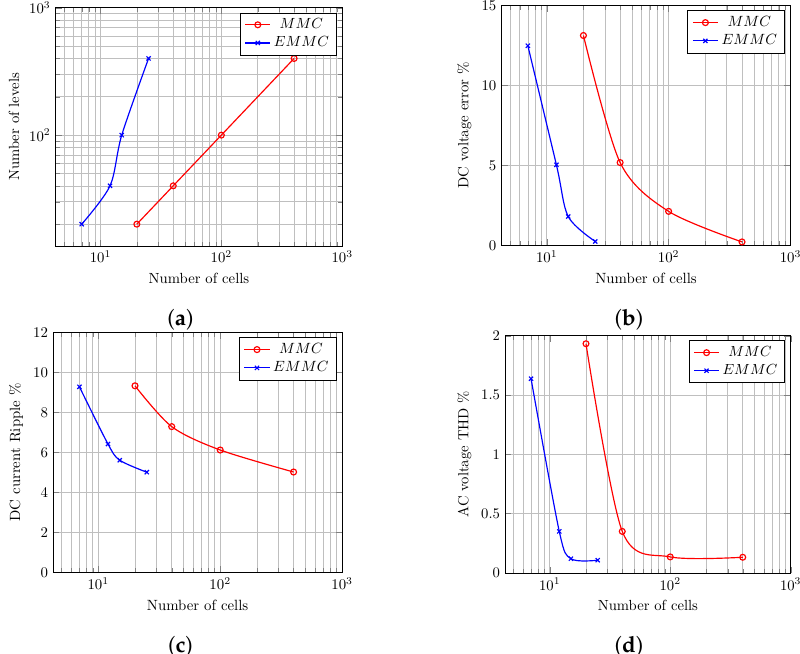
Figure 6. Scalability of EMMC compared to conventional MMC for various numbers of cells: ( a ) correlation between number of cells and number of levels produced in each arm, ( b ) common-mode DC voltage error, ( c ) DC current ripple, and ( d ) AC phase voltage